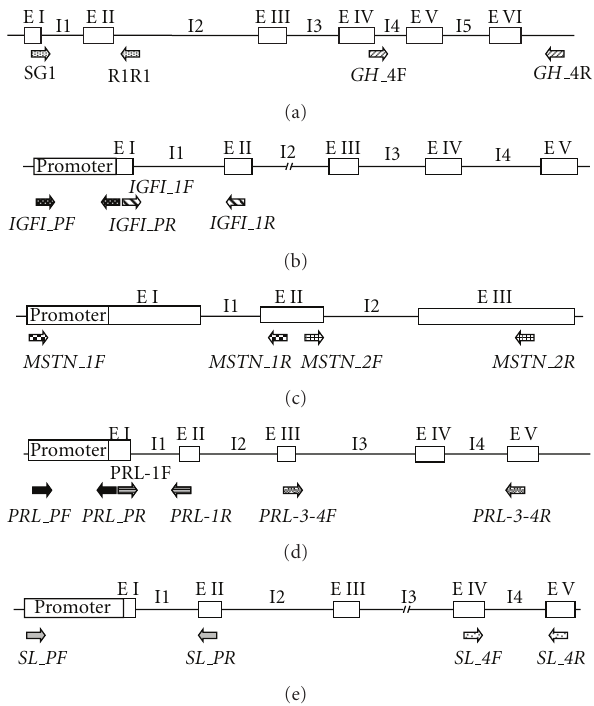
Figure 2: Structure of the candidate genes and oligonucleotide primers used for amplification by PCR in this study. Growth hormone (a), Insulin-Like Growth Factor I (b), Myostatin-1 (c), Prolactin (d), and Somatolactin (e) genes. I: Introns; E: Exons; Arrows indicate relative position of the